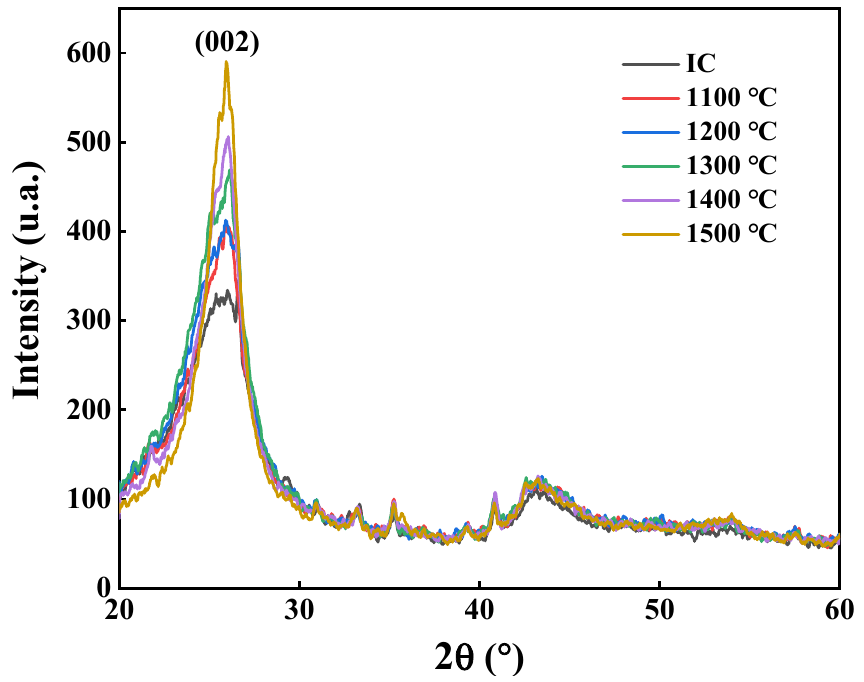
Figure 2. XRD patterns of coke at different temperatures. Table 3. Microcrystalline parameters of coke at different